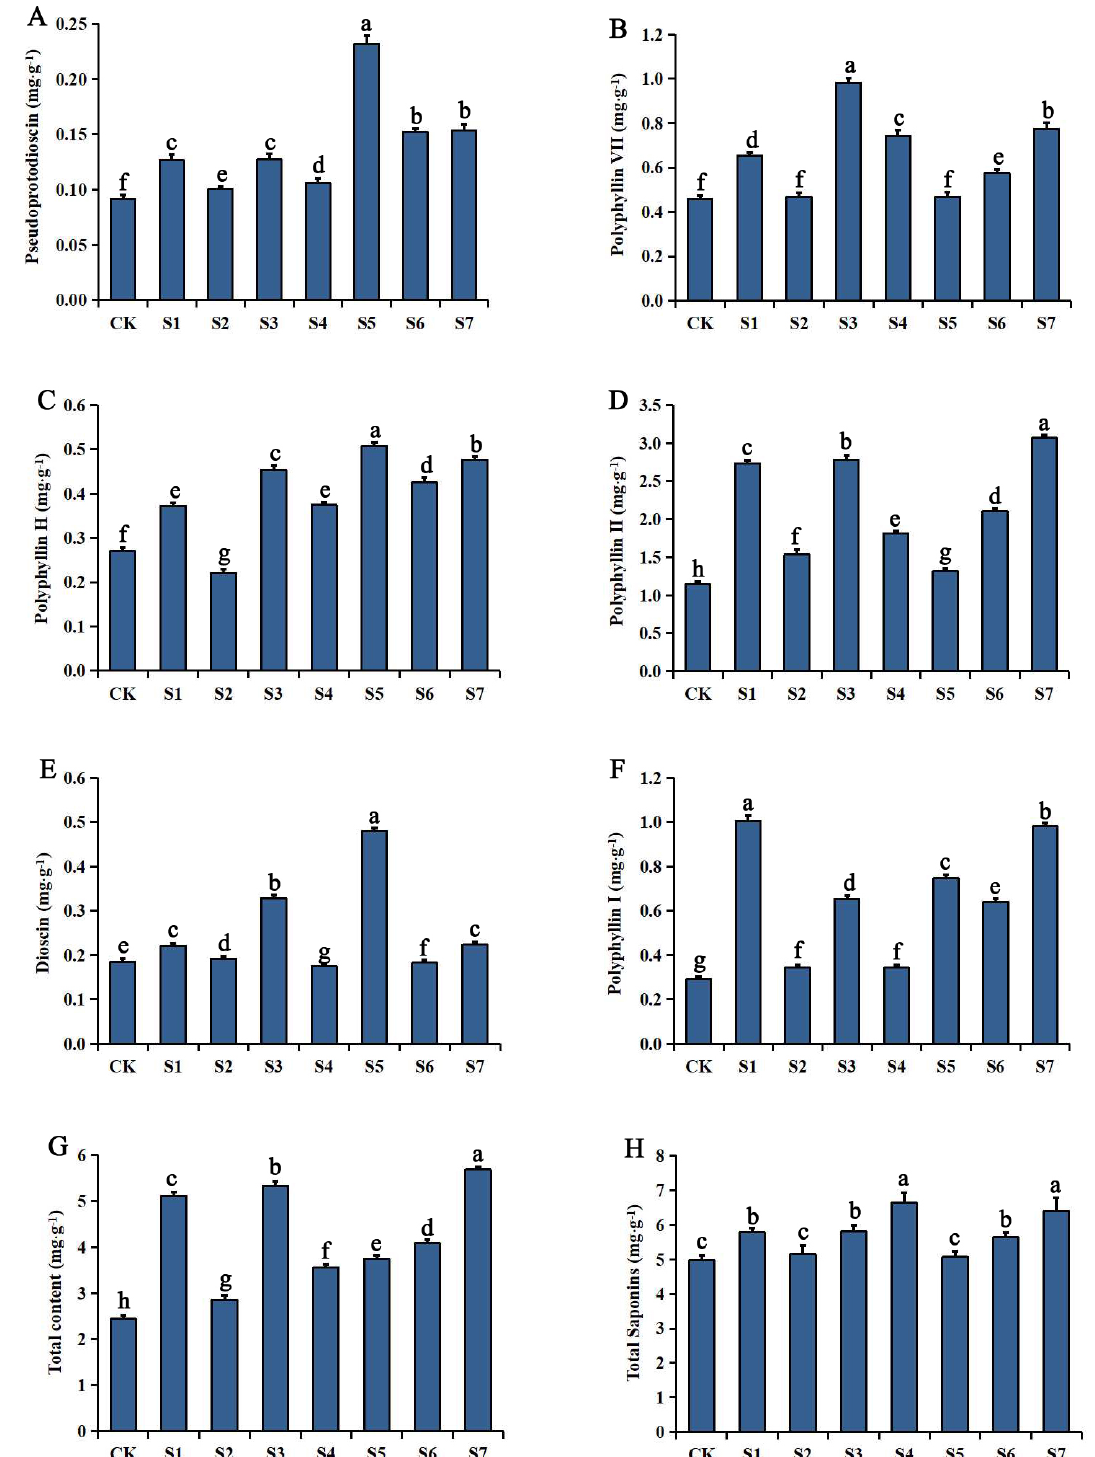
Figure 2. Effects of inoculation with OPDB on the steroidal saponin and total saponin concentrations of Paris polyphylla var. yunnanensis . ( A ) pseudoprotodioscin; ( B ) polyphyllin VII; ( C ) polyphyllin H; ( D ) polyphyllin II; ( E ) dioscin; ( F ) polyphyllin I; ( G ) total content; and ( H ) total saponins. Data (means ± SD, n = 3) followed by different letters above the bars indicate significant ( p < 0.05) differ- ences between treatments. Note: S1–S7 stand for Sample 1–Sample